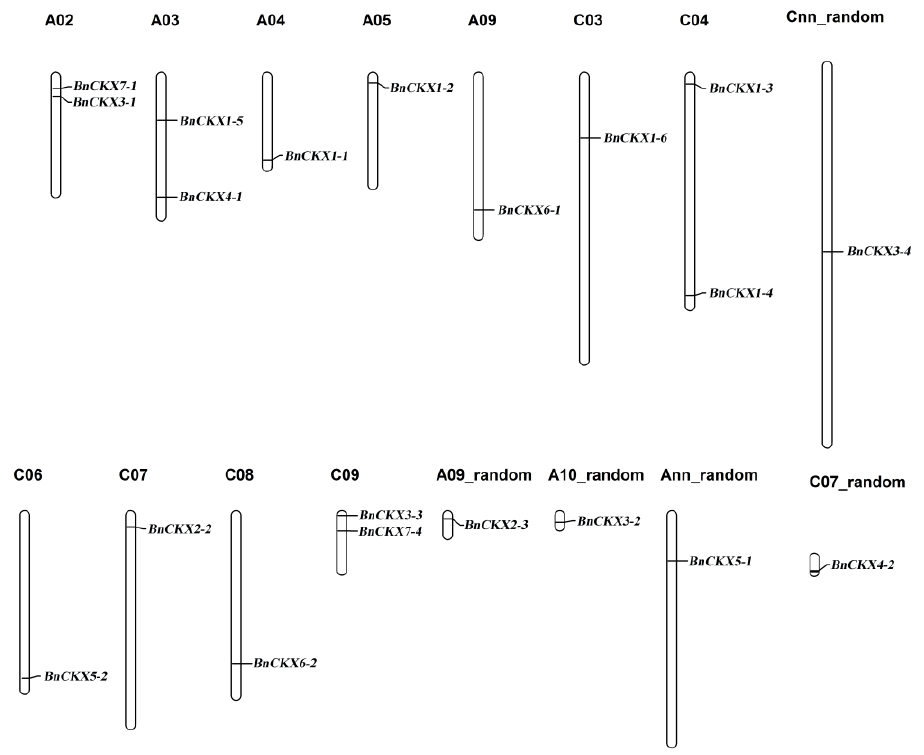
Figure 2. Distribution of BnCKX genes in the B. napus genome. The chromosomal position of each BnCKX gene was mapped to the B. napus genome: the chromosome number is indicated above each chromosome. The scale is in megabases (Mb). Ann and Cnn are pseudo-molecule chromosomes. Random: The specific position of gene is still unknown.